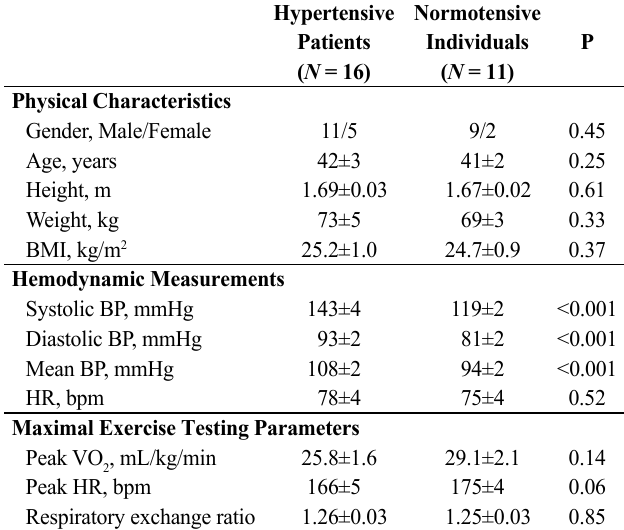
Table 1. Baseline Physical Characteristics, Hemodynamic Measure- ments, and Maximal Exercise Testing Parameters in Hypertensive Patients and Normotensive Individuals